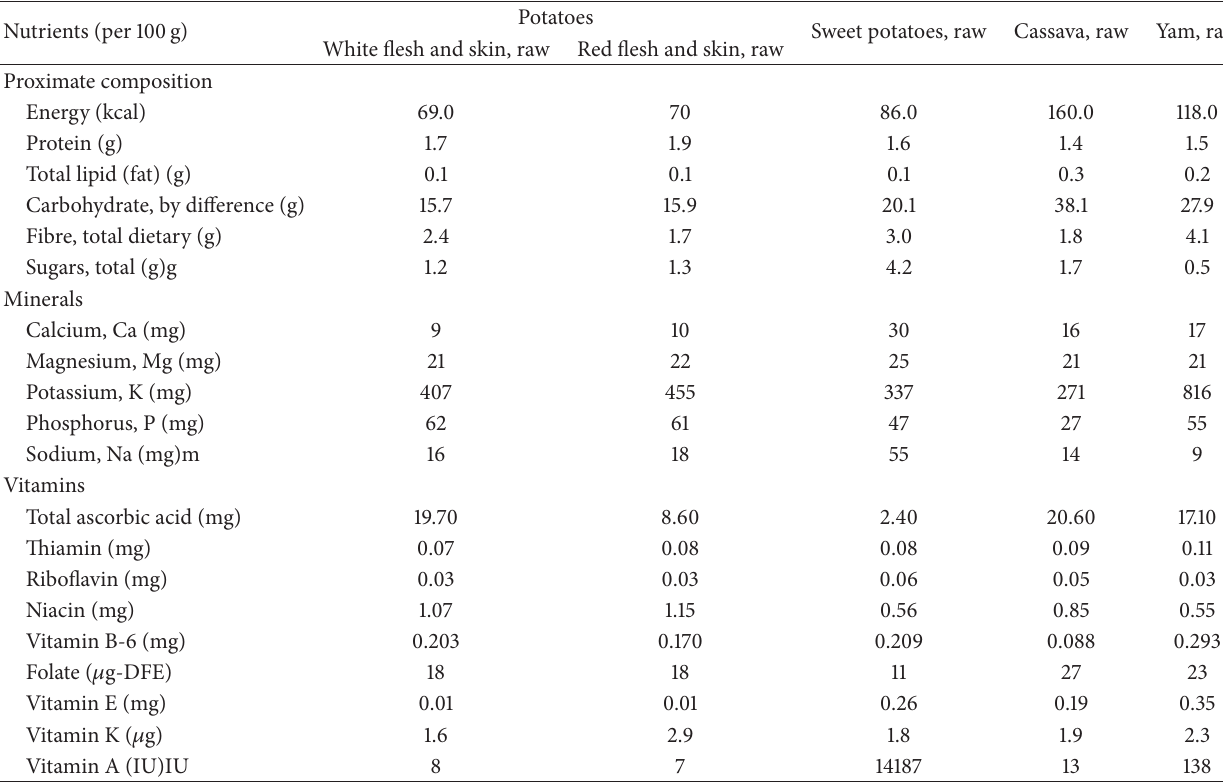
Table 1: Nutritional composition of selected tuber